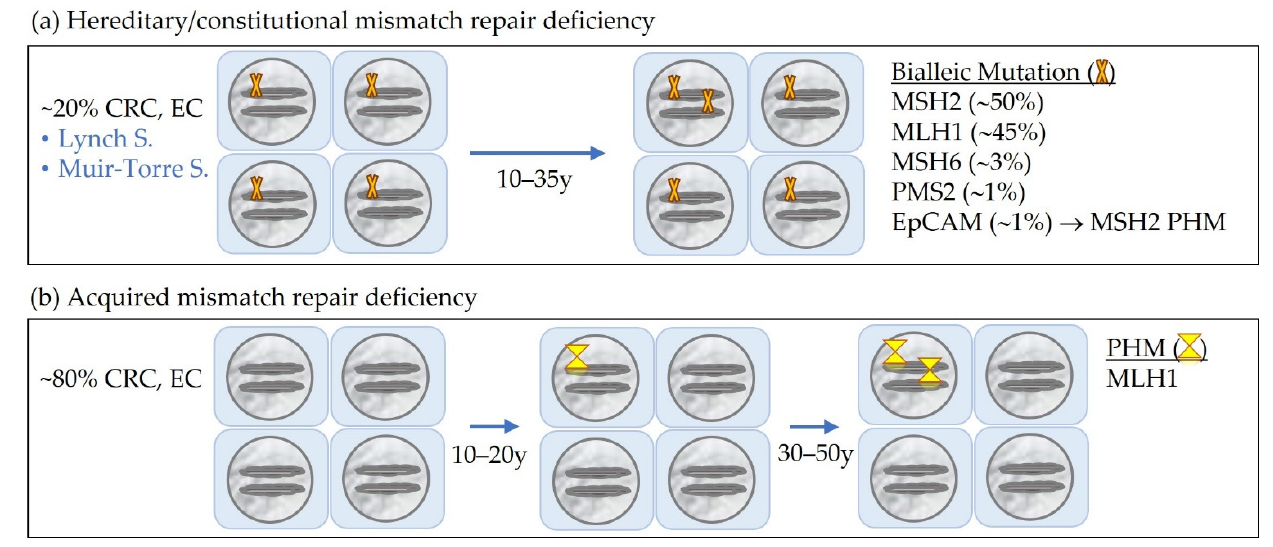
Figure 3. Depicted are the two different pathways for mismatch repair deficiency, i.e., hereditary ( a ) and acquired ( b ). S. = Syndrome; CRC = colorectal carcinoma; EC = endometrial carcinoma; PHM = promoter hypermethylation; y = year .